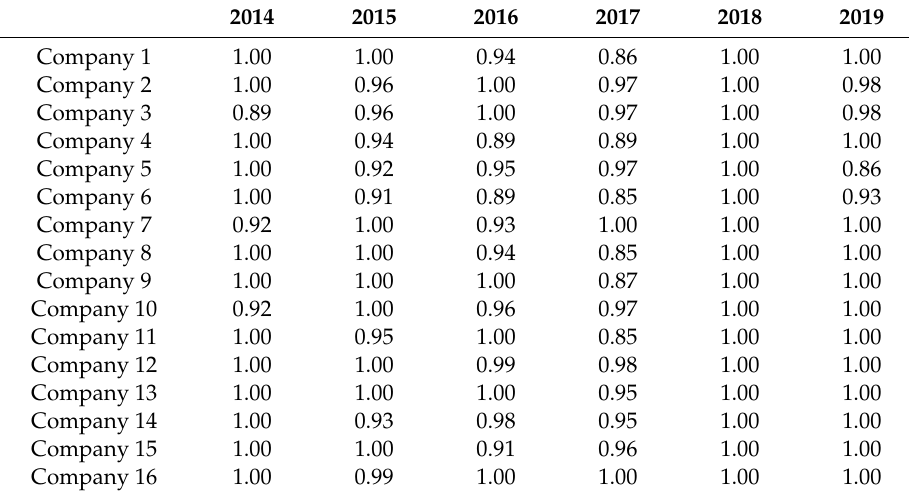
Table 13. Average e ffi ciency in CCR model for each